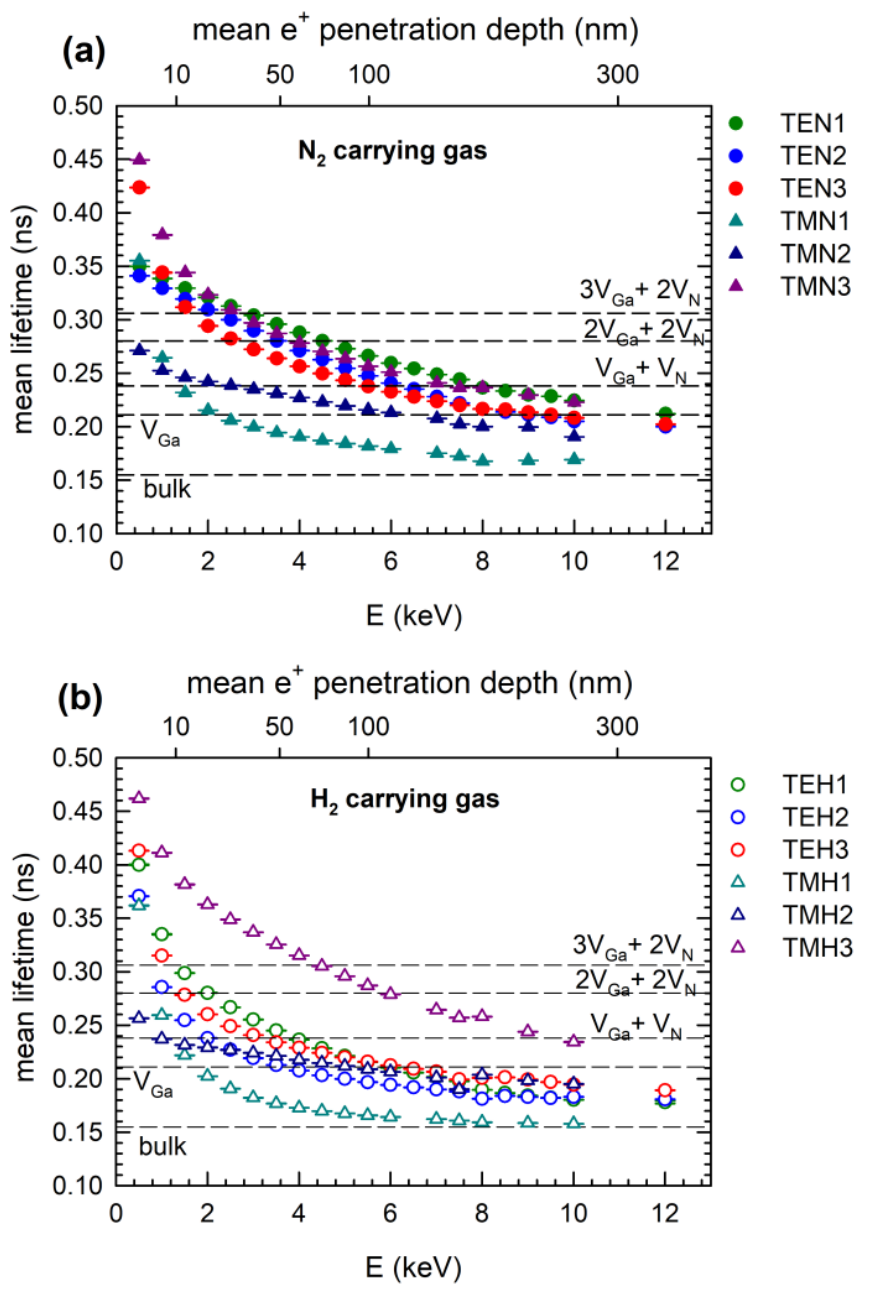
Figure 4. Dependence of the mean positron lifetime on the energy of incident positrons entering the GaN layer prepared under different growth conditions in ( a ) nitrogen and ( b ) hydrogen atmosphere. Upper x -axis shows the mean positron penetration